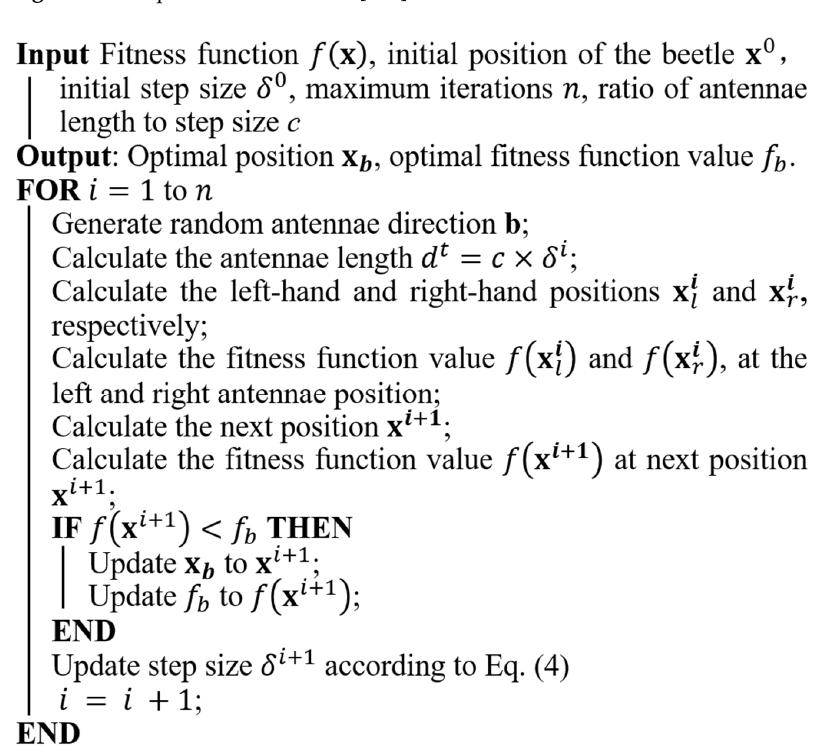
Figure 14. Pseudocode of BAS [105].